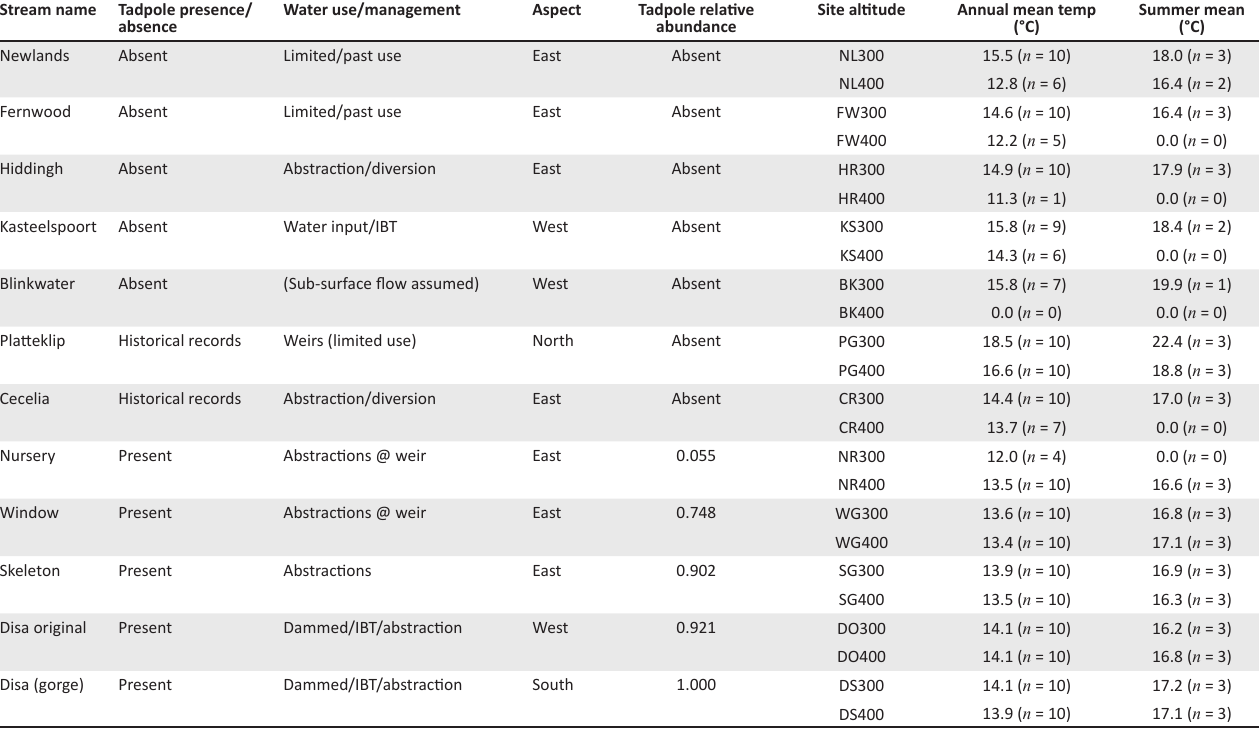
TABLE 2: The mean summer and mean annual temperatures (2014–2016), indicating permanence of flow ( n = 3 and n = 10